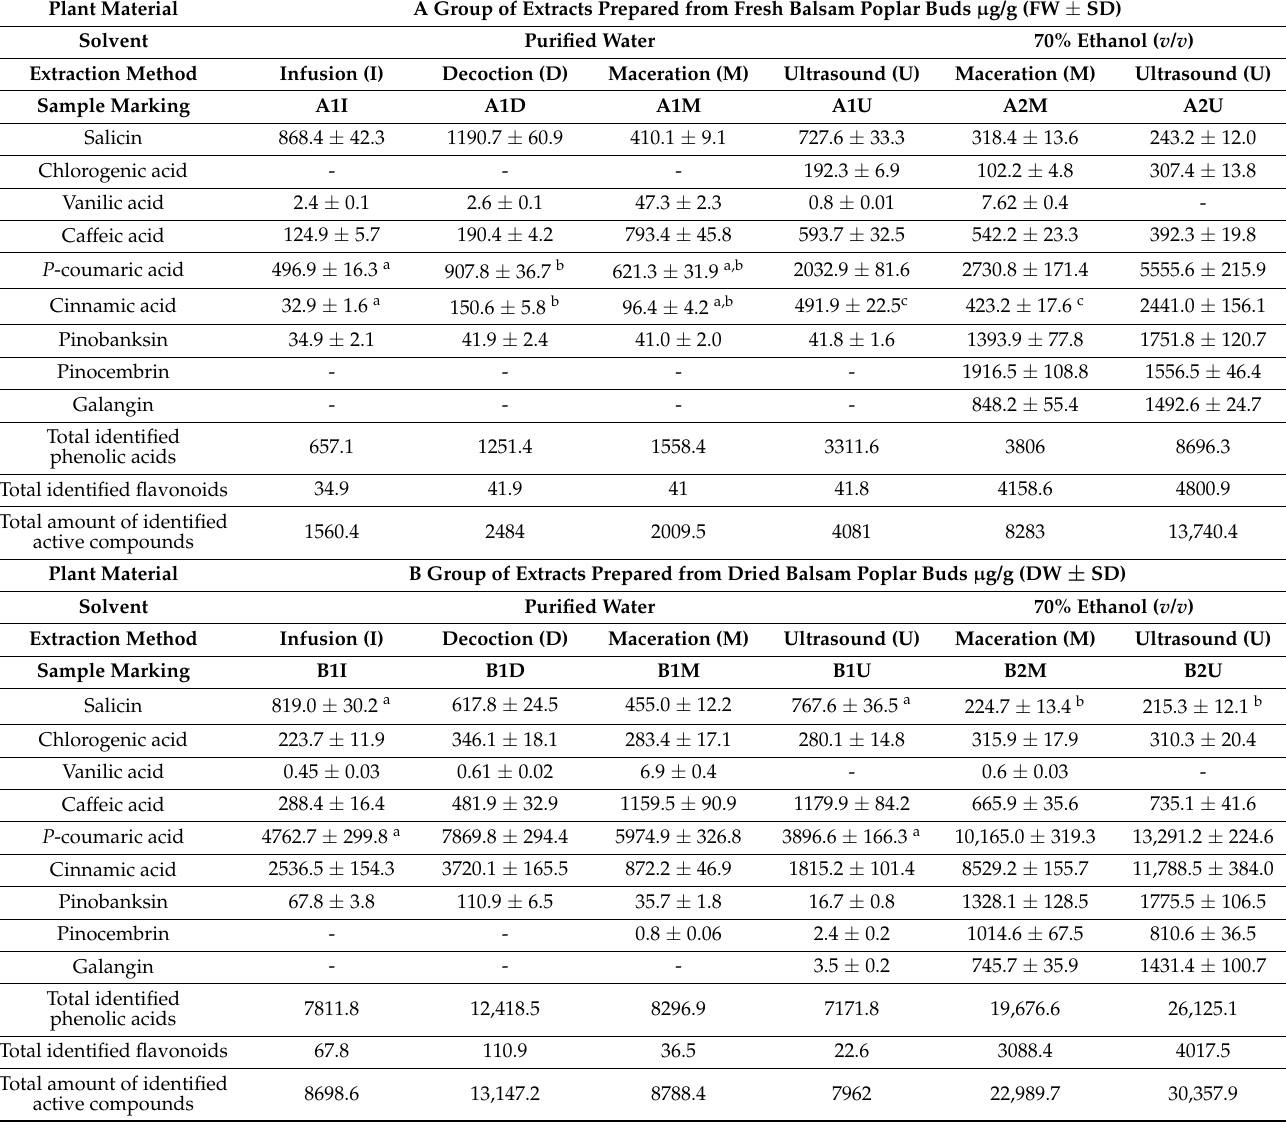
Table 2. HPLC analysis of 70% ethanolic ( v/v ) and aqueous balsam poplar bud extracts ( µ g/g Fresh weight (FW) ± standard deviation (SD), dry weight (DW) ± SD, mean, n = 3). Fresh and dried balsam poplar buds were used for extraction. The extracts made from fresh plant material are marked with the letter A, the extracts made from dried plant material are marked with the letter B. The extracts prepared by different methods are marked accordingly: I-infusions, D-decoctions, M-maceration, U-ultrasound. Different solvents were used for the extraction, which are denoted respectively: 1-purified water, 2-70% ethanol ( v/v ). Much higher concentrations of p -coumaric acid (F(1) = 1743.50, p < 0.001) and cinnamic acid (F(1) = 1682.93, p < 0.001) were found in the dried poplar buds compared to the fresh poplar